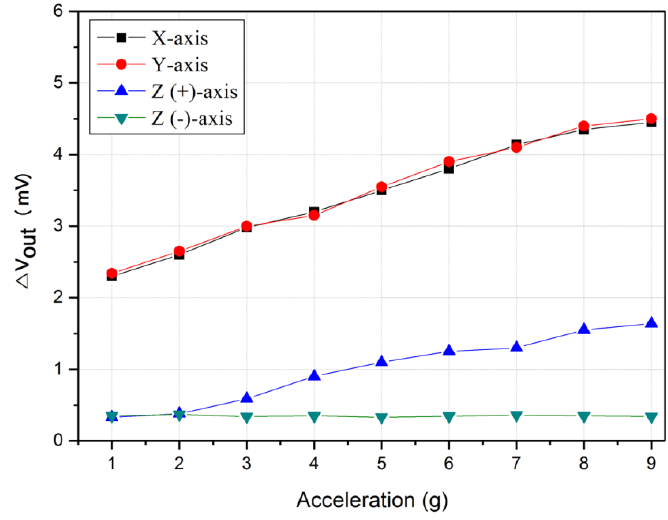
Figure 10. Output characteristic of the three-axis accelerometer.